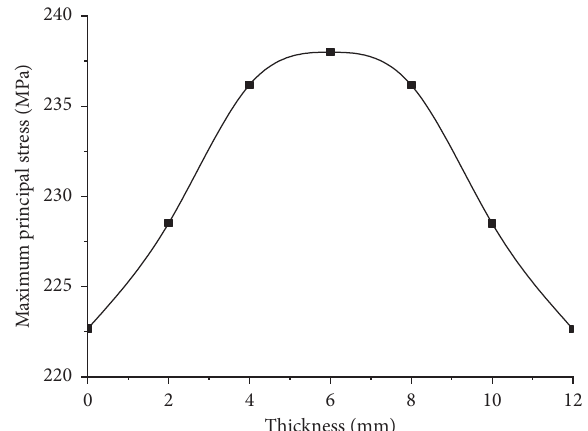
Figure 6: The trend of principal stress along the thickness of the hole under the preload.